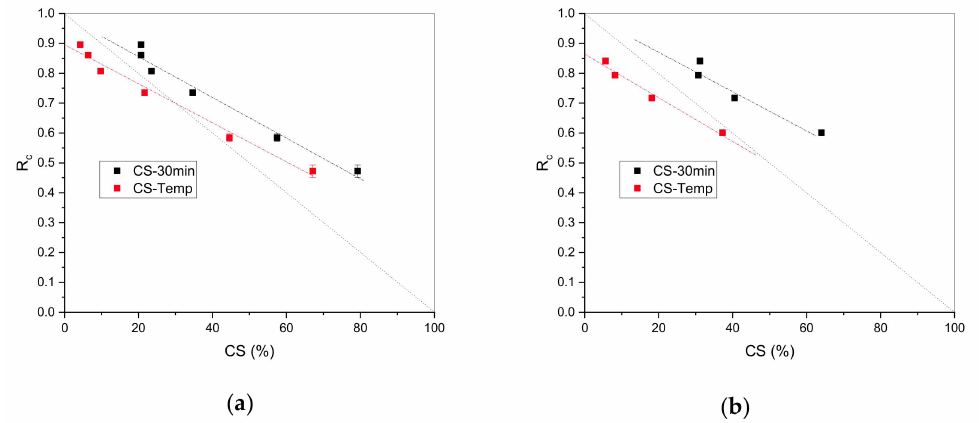
Figure 7. Continuous normalized stress relaxation ( R c ) versus the corrected CS ( % ) after 30 min and CS ( % ) after tempering for: ( a ) EPDM; ( b )